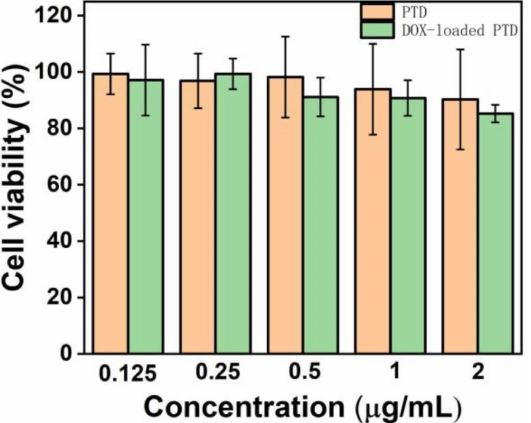
Figure 4. Survival rate of fibroblasts in different concentrations of blank and DOX-loaded PTD solution within 24